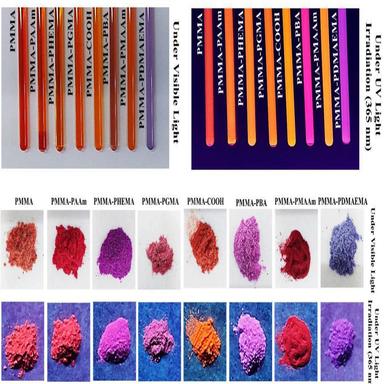
Solvatochromic properties of multi-color photoluminescent polymer nanoparticles in both colloidal solution and solid-state under visible-light and UV-light irradiations.